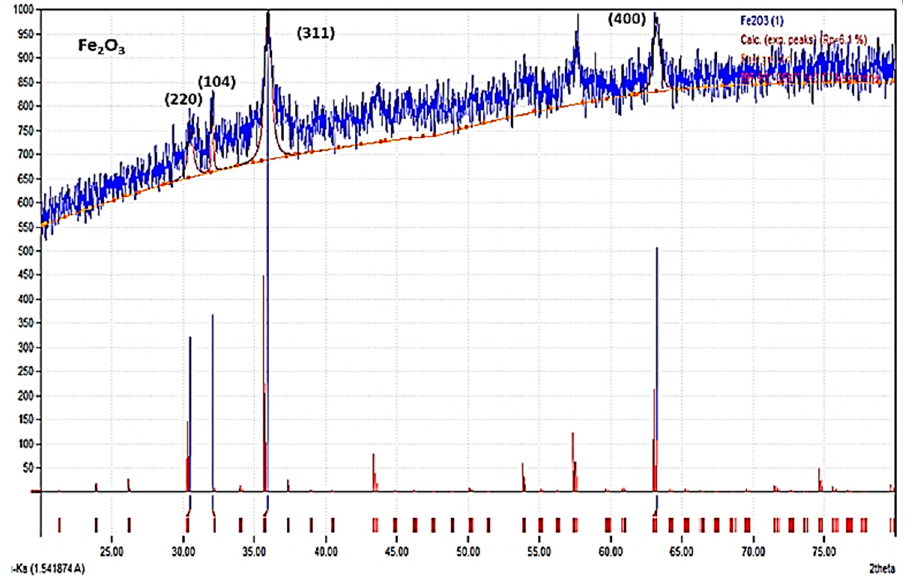
Figure 1. XRD Profile of iron oxides (Fe 2 O 3 ).